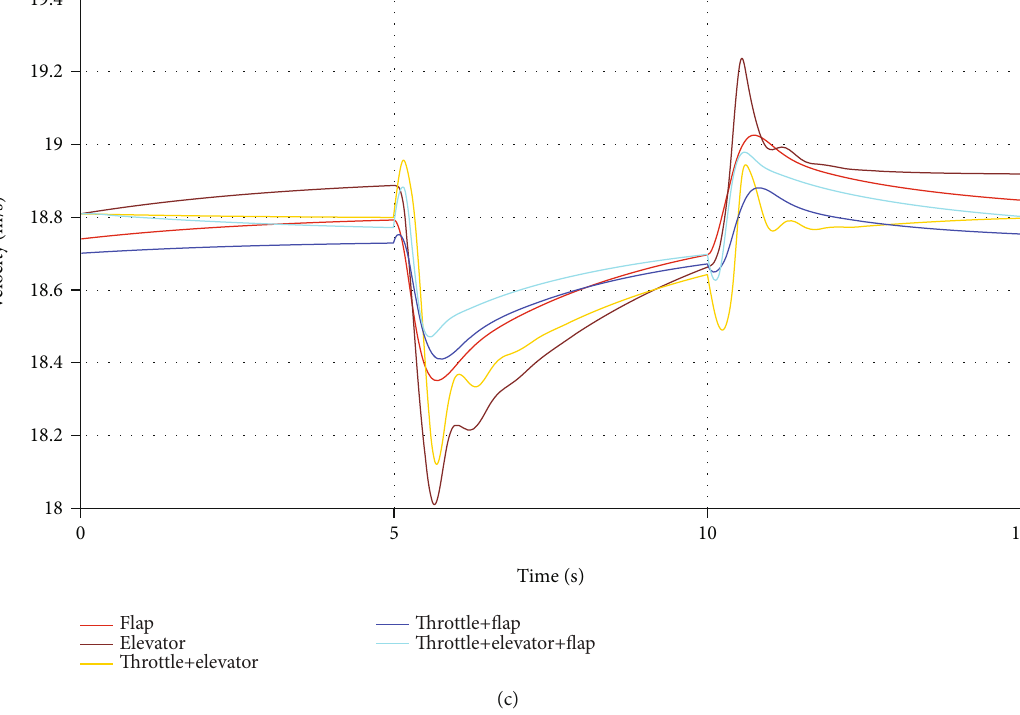
Figure 5: Comparison of free- fl ight simulation results for di ff erent control systems with 1m altitude disturbance. (a) Comparison of altitude change. (b) Comparison of pitch angle change. (c) Comparison of velocity